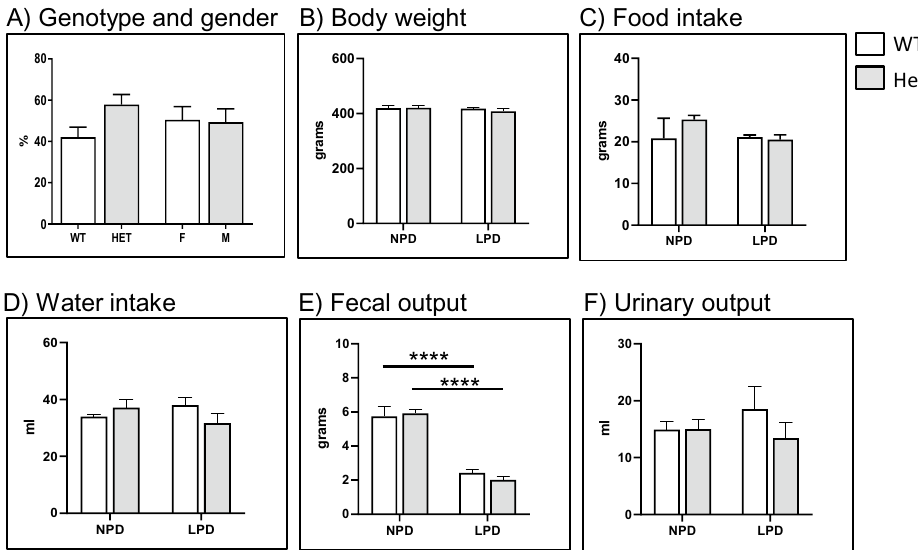
Figure 1. ( A ) Genotype and gender from pups from 9 litters born from two independent heterozygous Slc34a2 breedings. ( B ) body weight, ( C ) food intake, ( D ) water intake, ( E ) fecal output and ( F ) urinary output of wild type (n = 4) and heterozygous (n = 5) Slc34a2 rats fed standard chow (NPD) or challenged for 3 days with low Pi diet (LPD). Data are presented as means ±